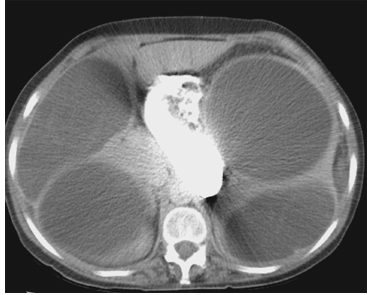
Figure 9. Computed tomography showing hydatid cysts of the liver and